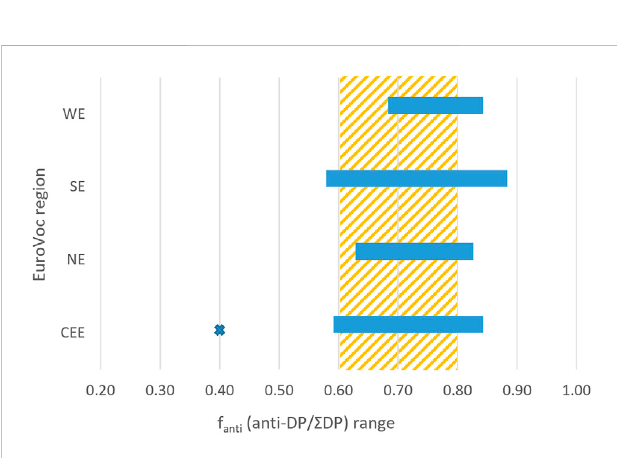
FIGURE 3 The range of theanti-DPfraction, f anti , for the four differentregions Western Europe (WE) ( n = 16), Southern Europe (SE) ( n = 9), Northern Europe (NE) ( n = 5) and Central-Eastern Europe (CEE) ( n = 6). The range of f anti in commercial mixtures of DP is indicated as the orange shaded area. An outlier in the CEE region (Czech Republic/Kosetice) is seen as a blue cross at f anti 0.4 and is discussed in the